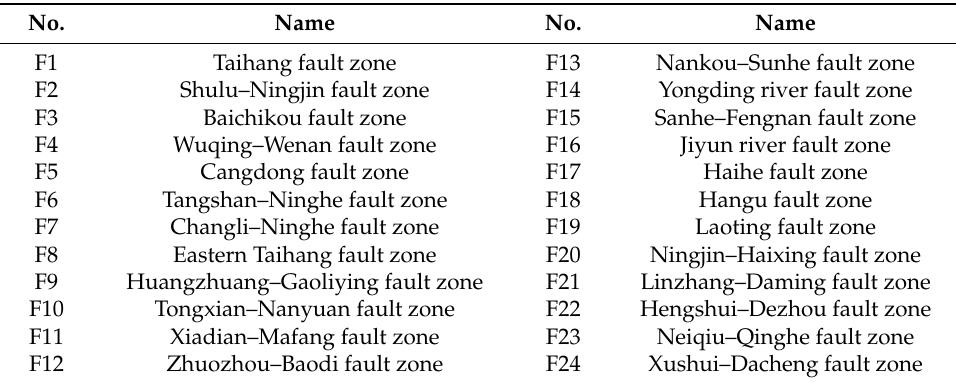
Table 4. Information on fault zones.